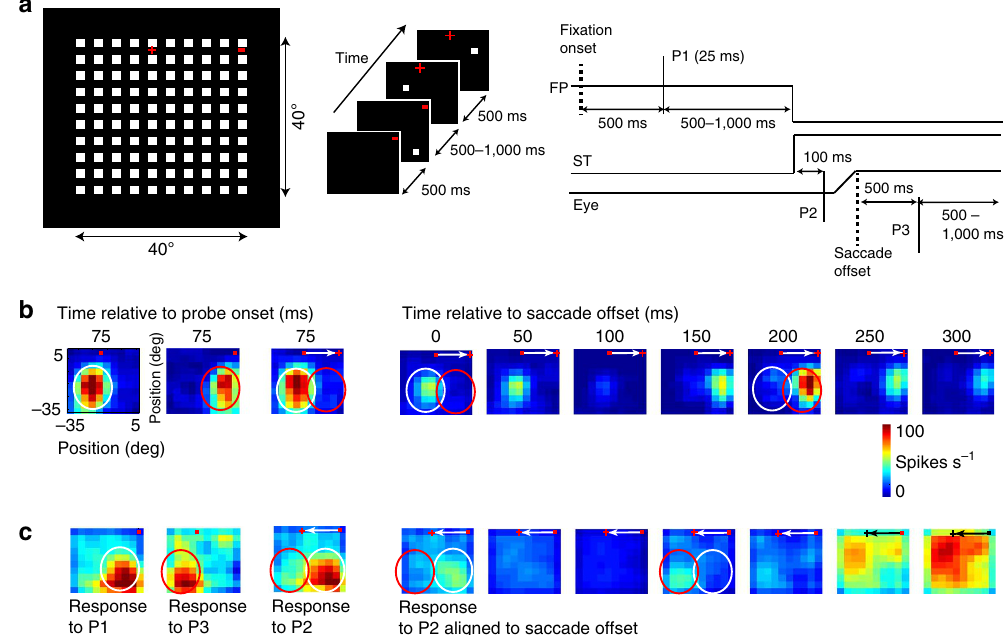
Figure 1 | Illustration of experimental paradigm and example neurons. ( a ) (left) All possible visual probe locations (10 (cid:2) 10 probe grid) spanning 40 (cid:2) of visual space (figure not drawn to scale for clarity). Fixation point (red dot) and saccade target (red ‘ þ ’) indicate the leftward direction of the horizontal, visually guided saccade in this example. (middle) Sequence of visual stimuli on an example trial, including the fixation targets and the appearance of the three probes at random locations. (right) Time course of a single trial. ( b ) Receptive field of an example neuron for probes flashed during fixation (left two panels; fixation points indicated by red dot) and those flashed immediately before an ‘away saccade’ (defined as a saccade directed horizontally away from the hemifield containing the receptive field) indicated by white arrows (third panel: responses aligned to probe onset; and fourth panel and onwards: responses aligned to saccade offset). ( c ) Receptive field of another example neuron for a ‘towards saccade’ (defined as a saccade directed horizontally towards the hemifield contacting the receptive field) (same scheme as in b ). FP, fixation point; ST, saccade